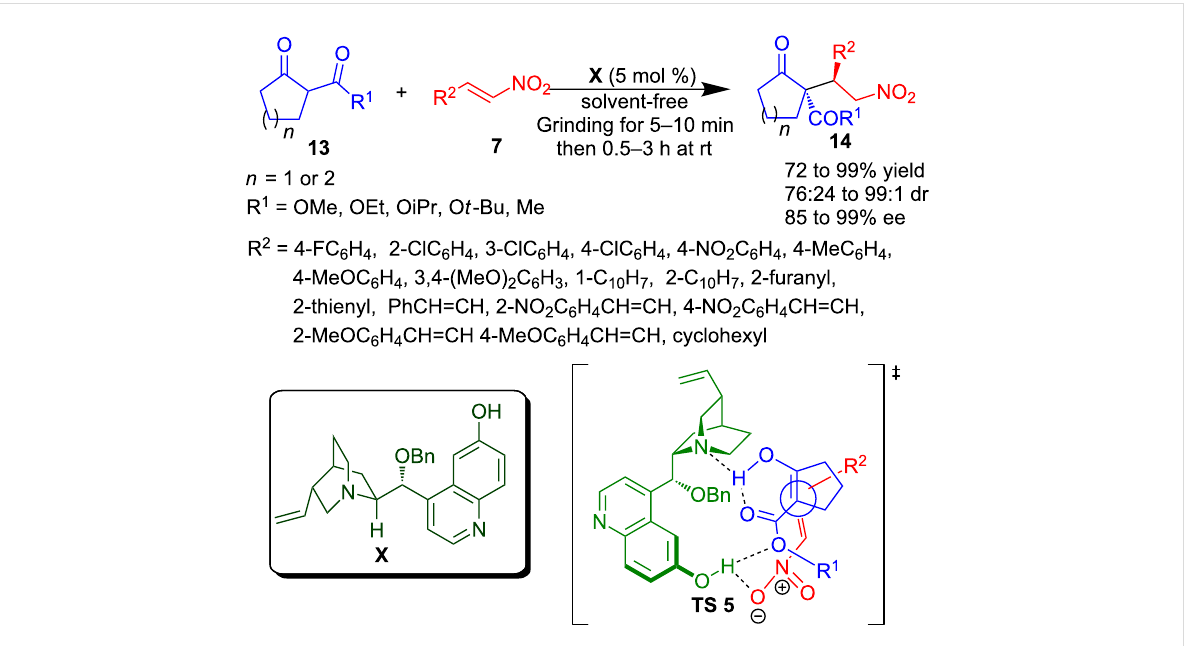
Scheme 8: Asymmetric organocatalytic Michael reaction assisted by pestle and mortar